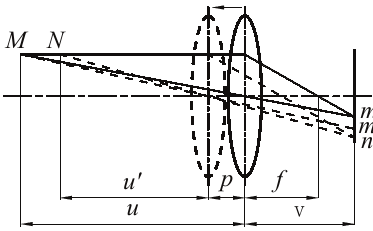
Figure 1. A scene point M at a distance of u from the lens is imaged in focus by an image detector at a distance of vfrom the lens with a focal length f . If the lens moves forward with a distance of p , M is imaged as a blurred circle around m (cid:48) , while the near scene point N at a distance of u (cid:48) from the lens is imaged in focus at n .